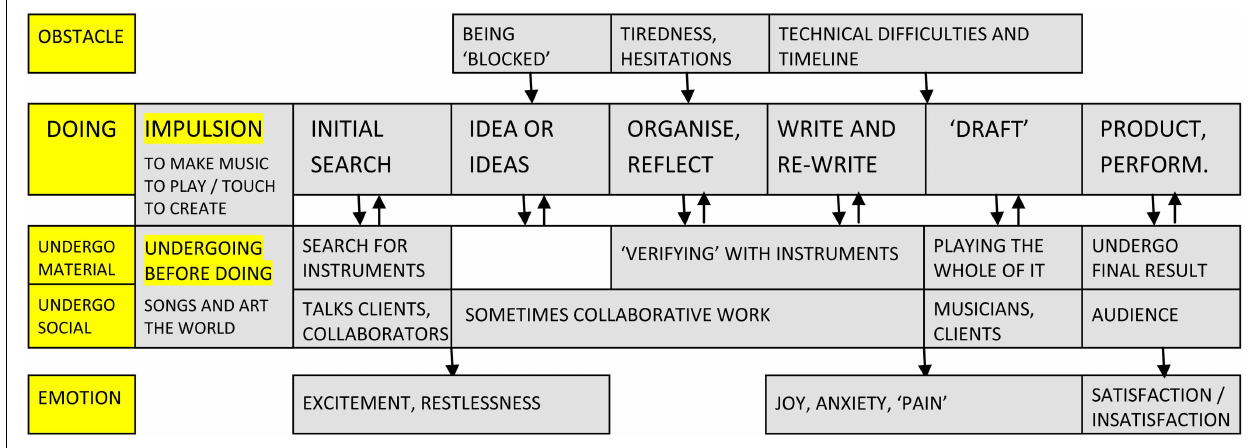
FIGURE 6 | Schematic representation of creative activity in the case of